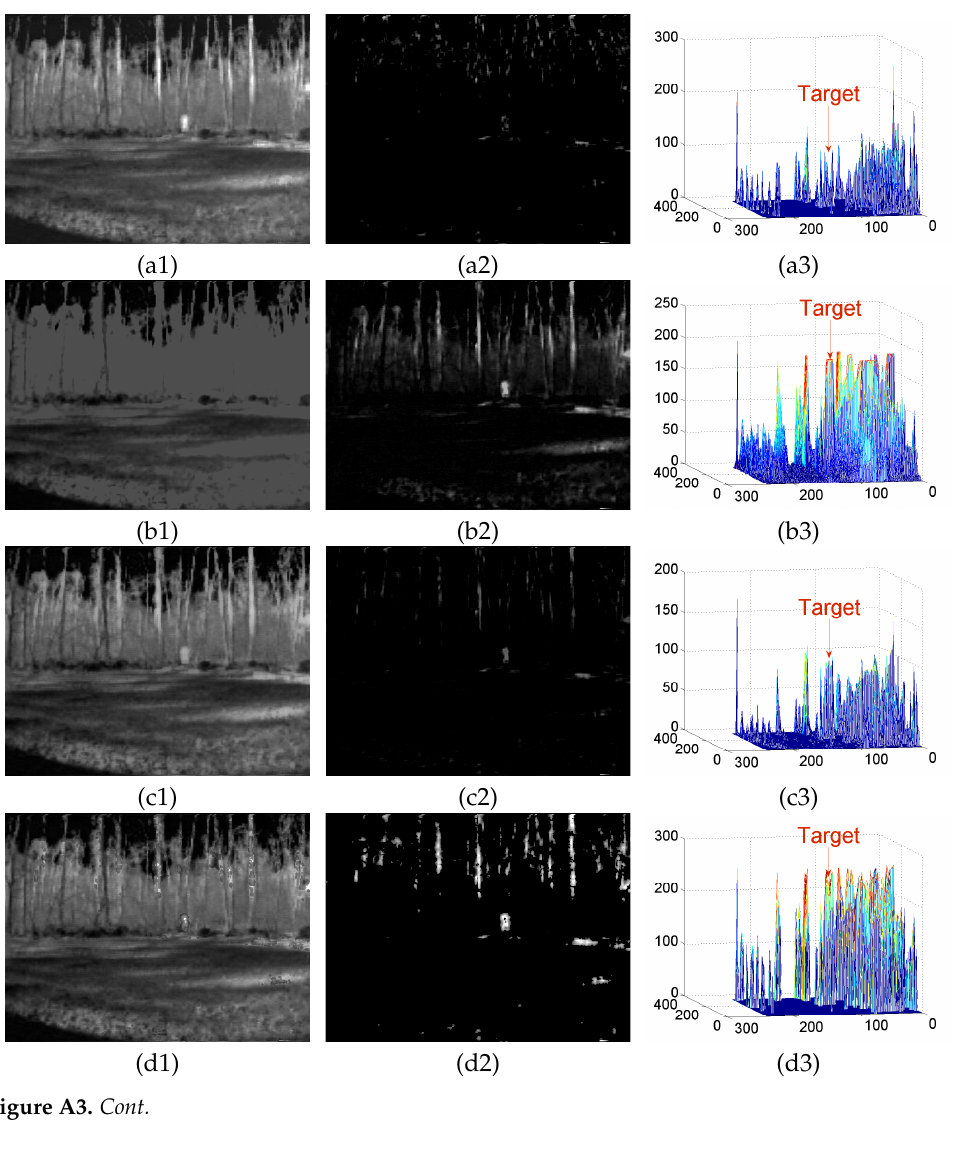
Figure A2. ( a – i ) denote the detection results of the PSTNN, RPCA, TV-PCP, VNTFR, ASTTV, SRWS, C2, C3, and proposed algorithm on sequence C, respectively, where ( a1 – a3 ) denote the background map, the differential map, and the 3D map of the obtained differential map, respectively.